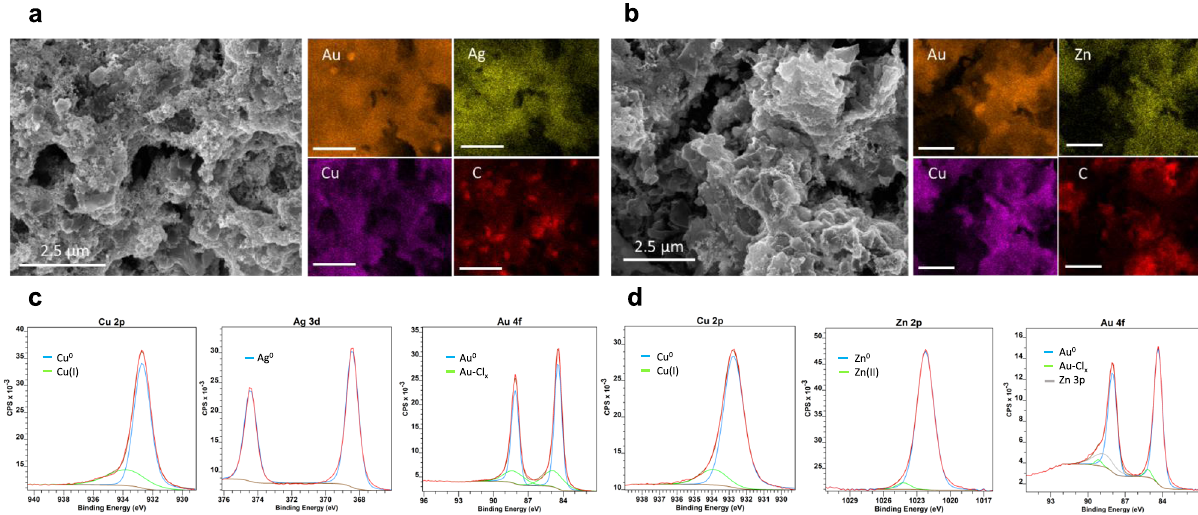
Fig. 4 Materials characterization of the ternary catalysts. a SEM image and EDS spectra for Au 6 Ag 2 Cu 2 and b for Au 4 Zn 3 Cu 3 . All scale bars in ( a and b ) are 2.5 µ m. c Cu 2 p , Ag 3 d , and Au 4 f XPS spectra for Au 6 Ag 2 Cu 2 . d Cu 2 p , Zn 2 p , and Au 4 f XPS spectra for Au 4 Zn 3 Cu 3